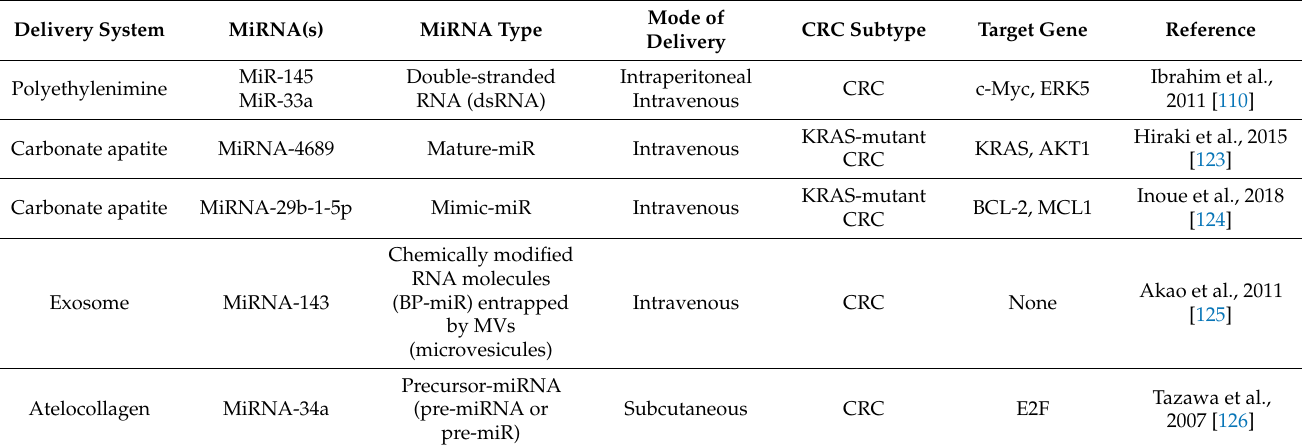
Table 4. Potential approaches for miRNA therapeutic